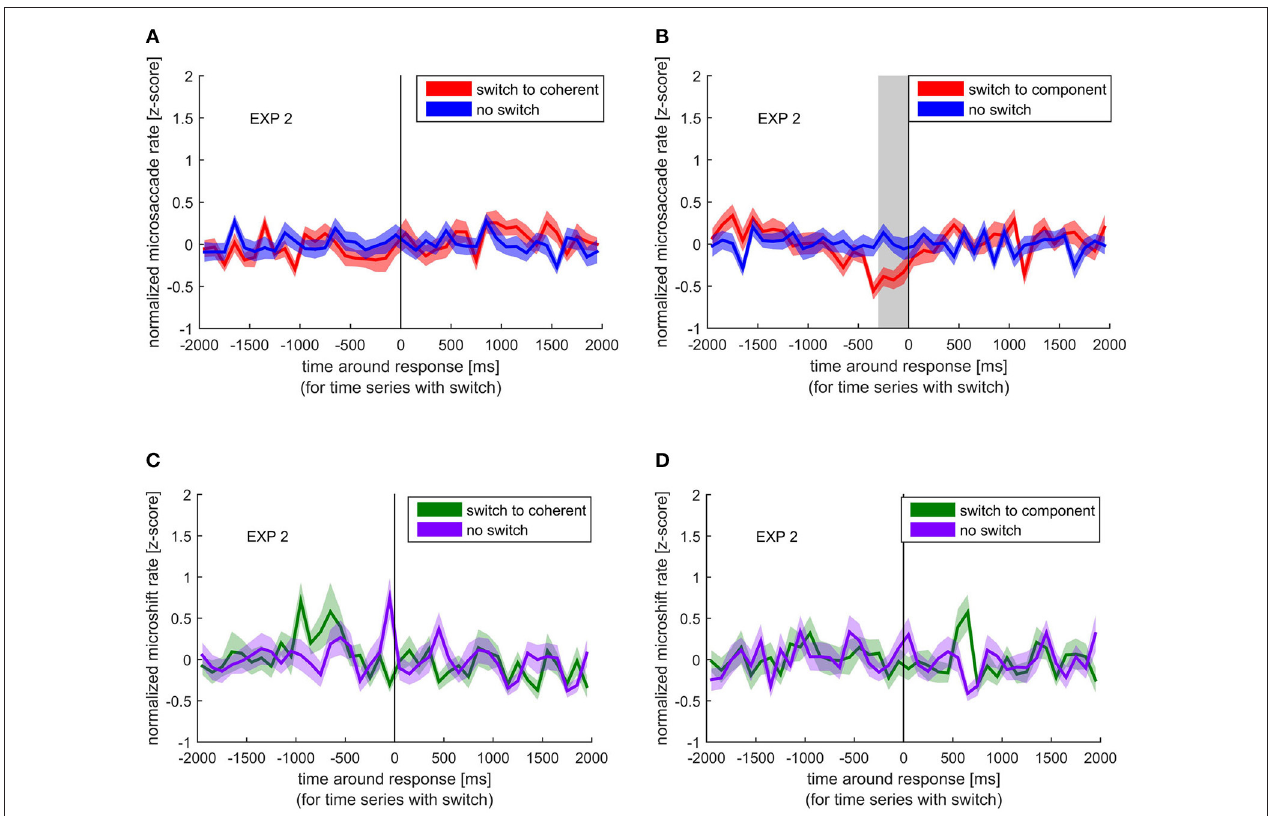
FIGURE 4 | Normalized microsaccade/microshift rate around the response indicating a perceptual switch (red/green) compared with the normalized microsaccade/microshift rate during no switch (blue/ purple). Colored lines and ribbons represent mean ± SEM. Vertical shaded area marks significant time points revealed by the non-parametrical statistical test procedure described by Maris and Oostenveld (2007). (A) Microsaccade rate around switch to coherent motion. (B) Microsaccade rate around switch to component motion. (C) Microshift rate around switch to coherent motion. (D) Microshift rate around switch to component